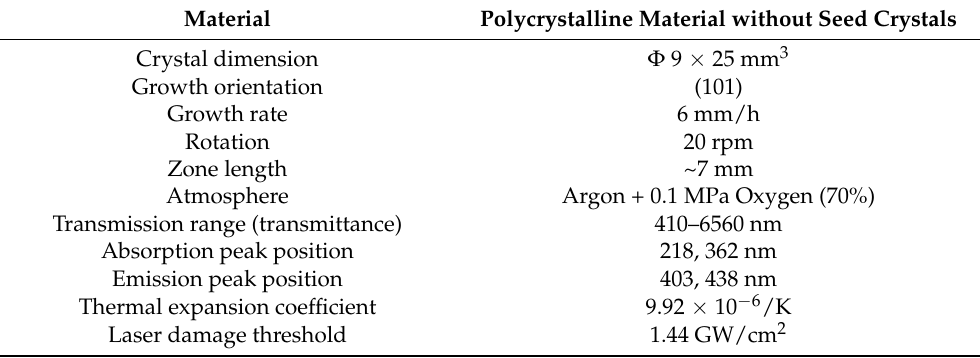
Table 1. Summarized parameters of grown crystals.